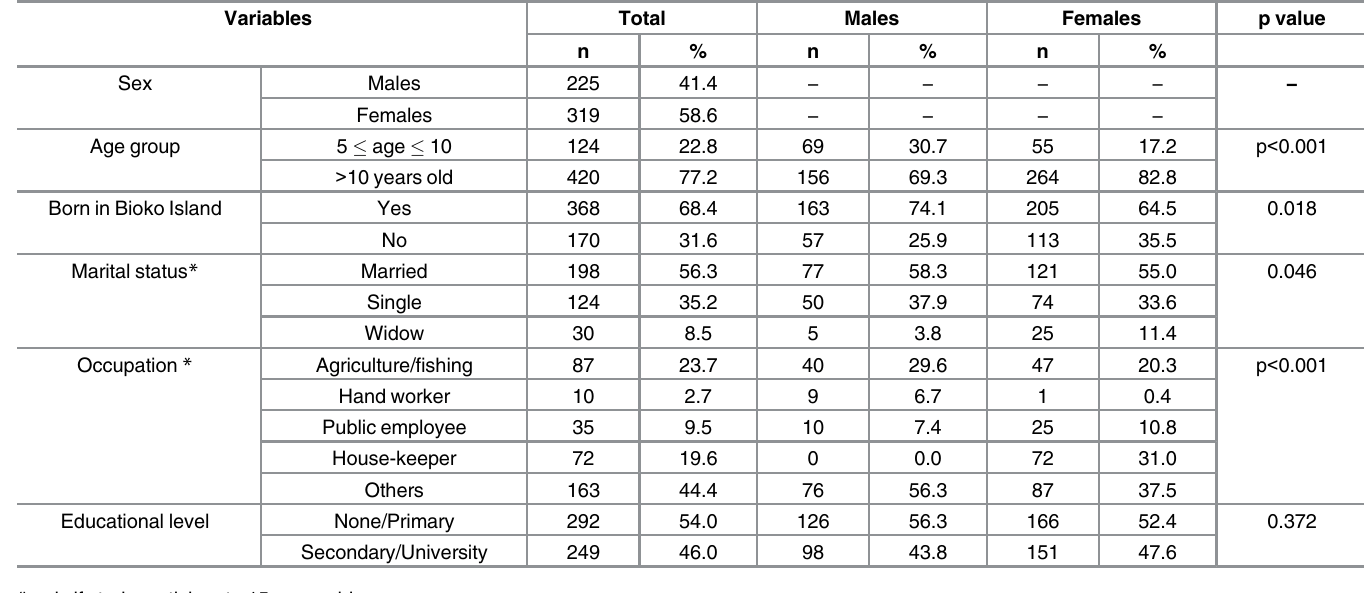
Table 1. Socio-demographic characteristics of the study population, Bioko Island, Equatorial Guinea, January 2014 (n = 544).